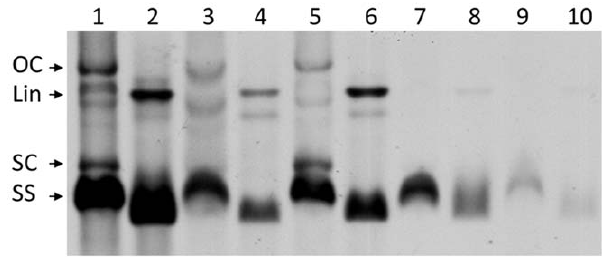
Figure 3. Southern blot analysis of SPLCLaV infected plants. DNA was isolated from I. nil (lanes 1–2), N. benthamiana (lanes 3–4), I. setosa (lanes 5–6) and sweet potato cv. ‘Beauregard’ (lanes 7–8) plants agroinfected with pDIM-BG30-7-BIN, and I. purpurea (lane 9–10) plant infected by grafting. Lanes 2, 4, 6, 8 and 10 correspond to DNA digested with Bam HI. Positions are indicated for the single-stranded genomic DNA (ss) and double-stranded replicative DNA forms [supercoiled (SC), linear (Lin) and open circular